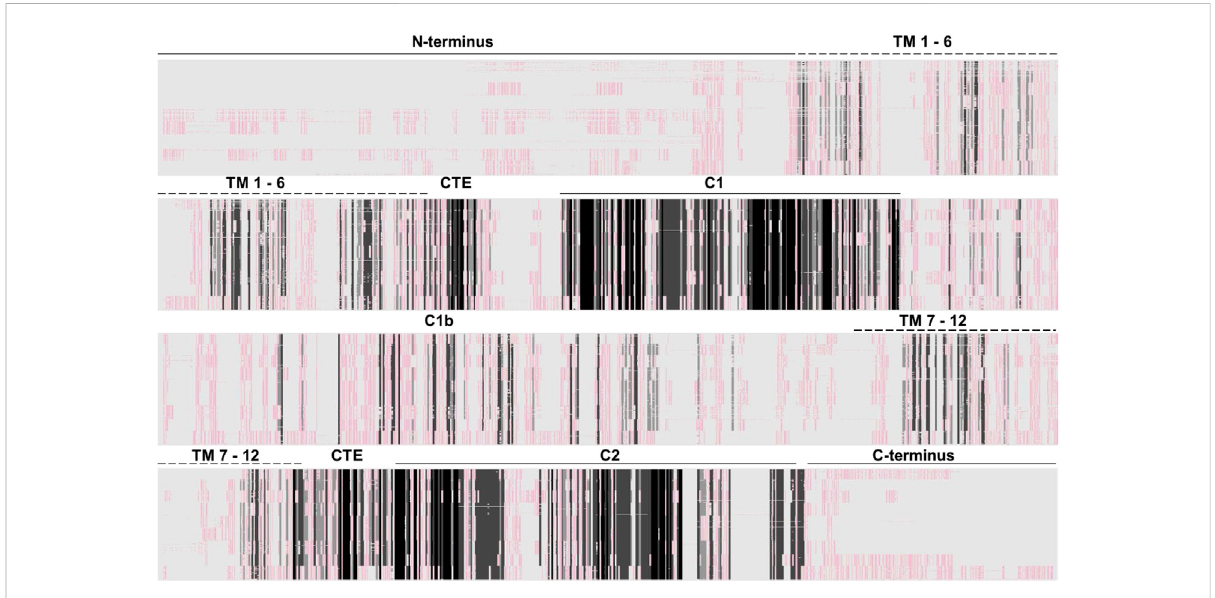
FIGURE 3 Alignmentof258classIIIadenylylcyclasesaboutequallycomprisedofallnineisoforms(AC126sequences;AC2,25;AC3,29;AC4,30;AC5,28; AC6, 30; AC7, 33; AC8, 28; AC9, 29). The approximate domain borders are indicated above. Clearly, the catalytic domains are cognizable as dark- shaded sections. All other domains, i.e., cytosolic N-and C-termini, the membrane domains and the cytosolic C1b linker are not conserved. The Clustal W alignment was adapted and shaded using the programme GeneDoc (http://nrbsc.org/gfx/genedoc/). Shading: black, invariant; dark grey, highly conserved; light grey, slightly conserved; whitish/reddish: fully diverged. A list of all mACs used for the alignment is attached at the